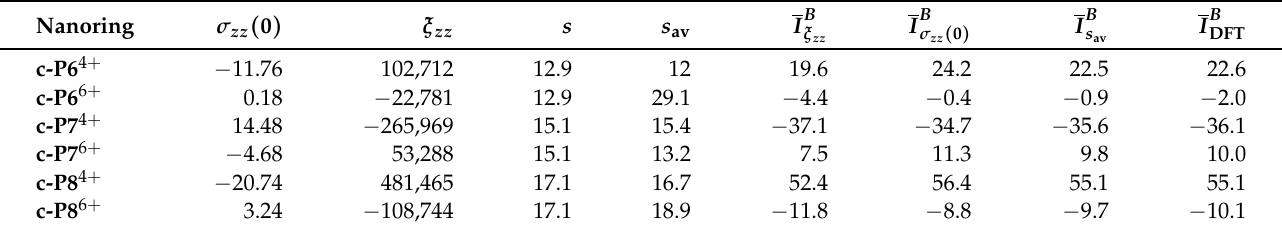
Table 2. Estimation of the signed current strength of the nanorings from the magnetic properties computed at the BHandHLYP/6-31G* level. Nuclear magnetic shielding and magnetizability components σ zz ( 0 ) and ξ zz in ppm and